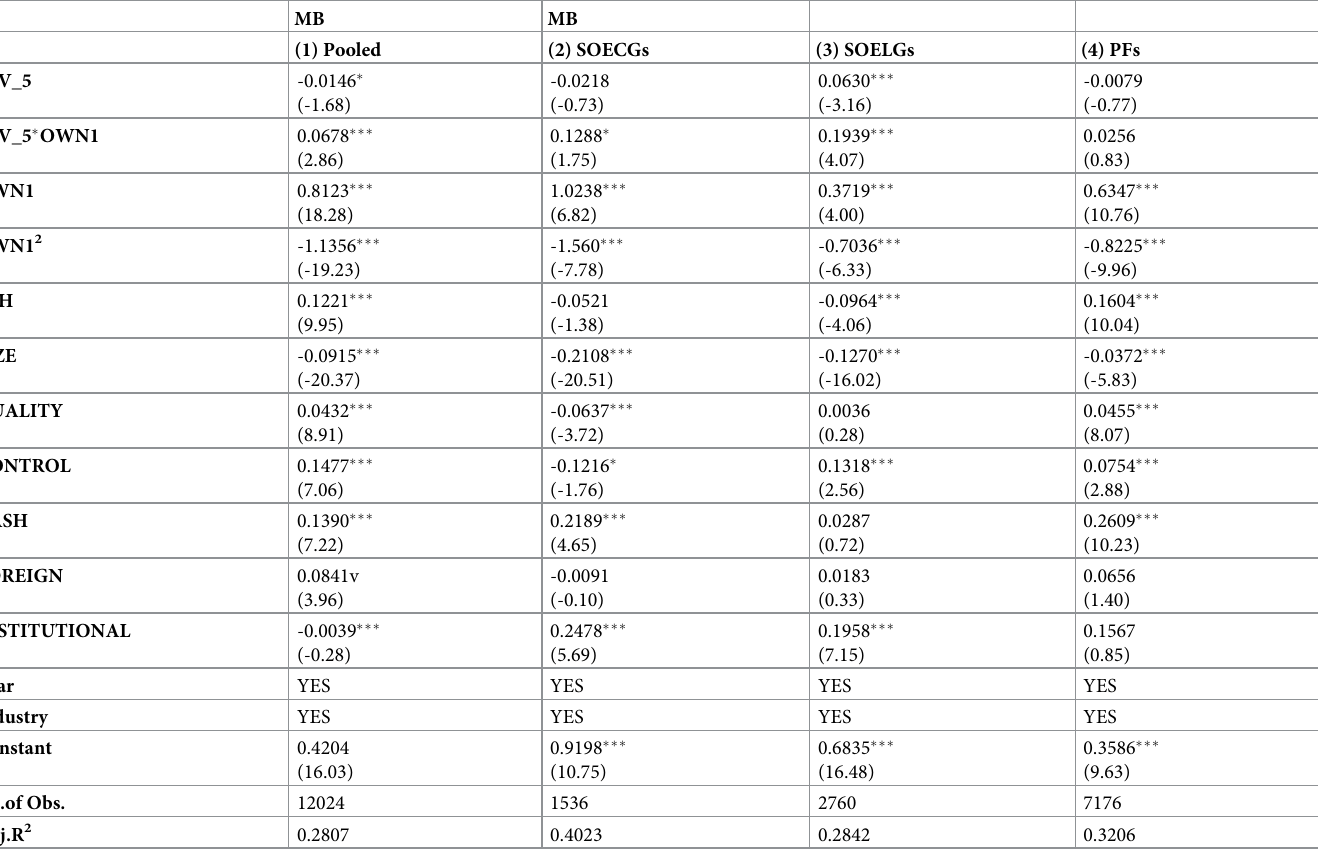
Table 5. Endogeneity of ownership concentration and firm value: Using OWN i, t-1 as instrument variable. MB